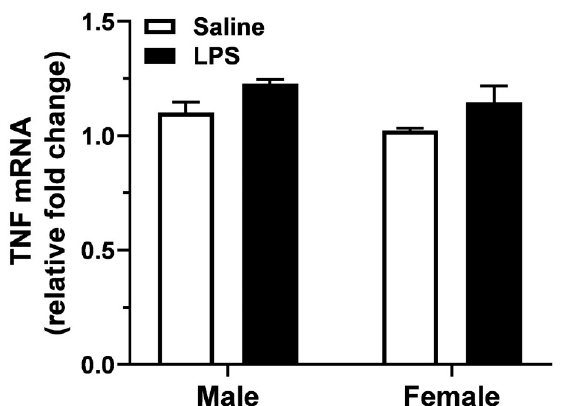
Figure 2. Hippocampal TNF mRNA levels, 24 h following the administration of LPS. There was an overall effect of treatment on the levels of TNF mRNA expression by two-way ANOVA, which did not reach significance in male and female mice ( p > 0.05, Bonferroni post hoc tests). Results are the mean ± SEM of n = 3–4 animals per group. Mice survived for 24 h after the injection of 0.5 mg/kg LPS.